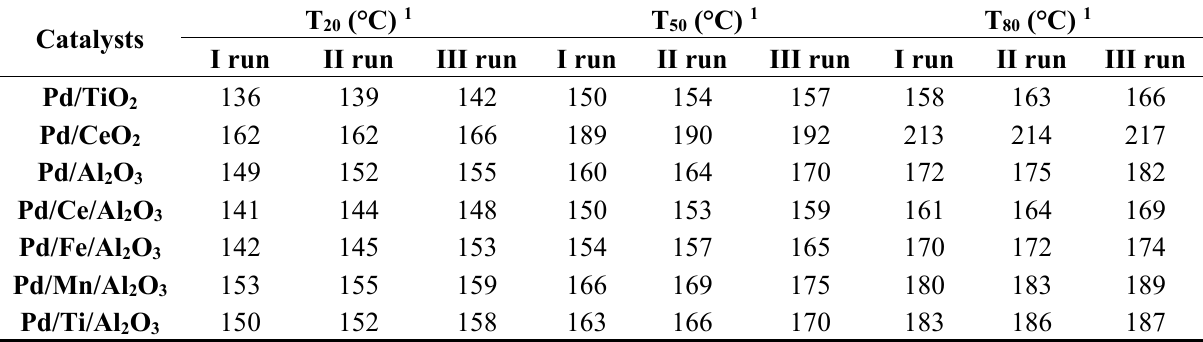
Table 4. Catalytic performances of the Pd-supported catalysts on the propene oxidation during the cooling ramp (third catalytic